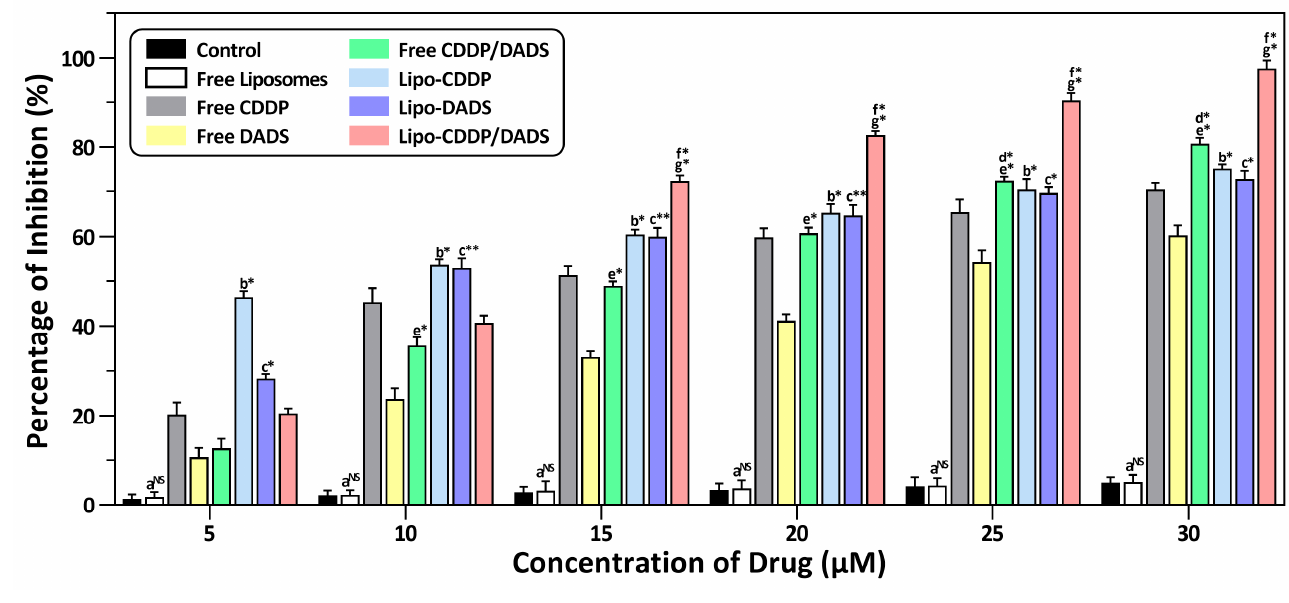
Figure 5. In vitro cytotoxic effect by control, free drugs, and drug(s)-loaded nanoliposomes on MDA-MB-231 cell line. Results are shown as mean ± standard deviation ( n = 3). Group a, control vs. free liposome; Group b, free CDDP vs. Lipo-CDDP; Group c, free DADS vs. Lipo-DADS; Group d, free CDDP vs. free CDDP/DADS; Group e, free DADS vs. free CDDP/DADS; Group f, Lipo-CDDP vs. Lipo-CDDP/DADS; Group g, Lipo-DADS vs. Lipo-CDDP/DADS. * p ≤ 0.05, significance; ** p ≤ 0.01, most significance; NS, non-significance.